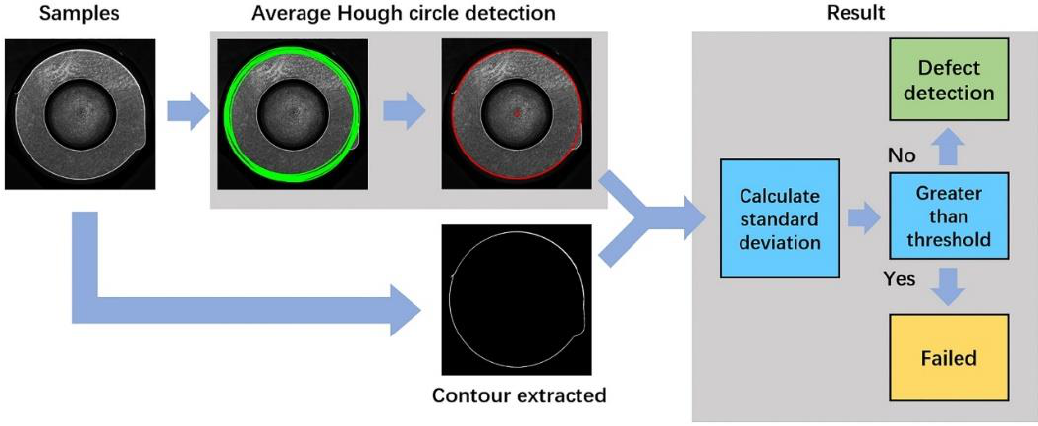
Figure 5. Surface inspection process. CNN: Convolutional Neural Networks; ROI: Region of Interest.